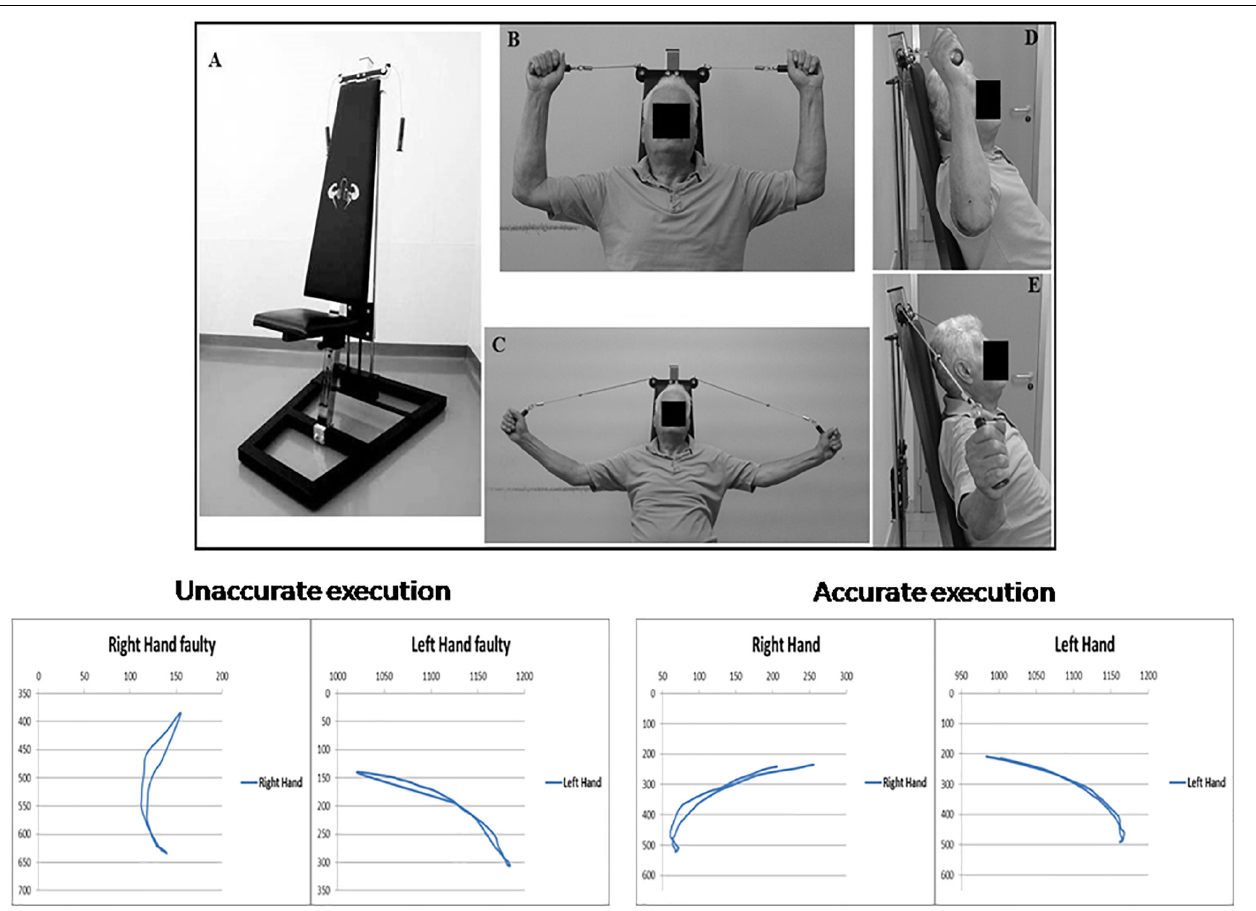
FIGURE 1 | Top: Angel’s Wings device (A) ; frontal (B) and lateral (D) views of the starting position of the exercise; frontal (C) and lateral (E) views of the distension of the forearms. At the bottom of the figure, on the right, are shown the trajectories (in pixels) of both hands required for a correct execution of the exercise with Angel’s Wings device, in an exemplificative patient. On the left are shown the trajectories obtained in the same subject before an appropriate period of learning of the exercise. A written, informed consent was obtained from the subject represented in the